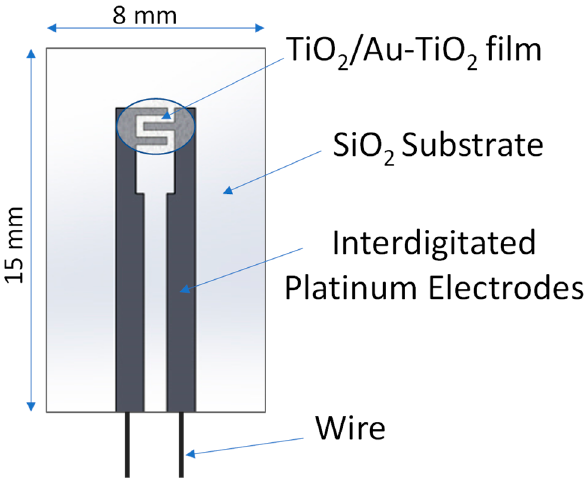
Figure 1. Test device structure.